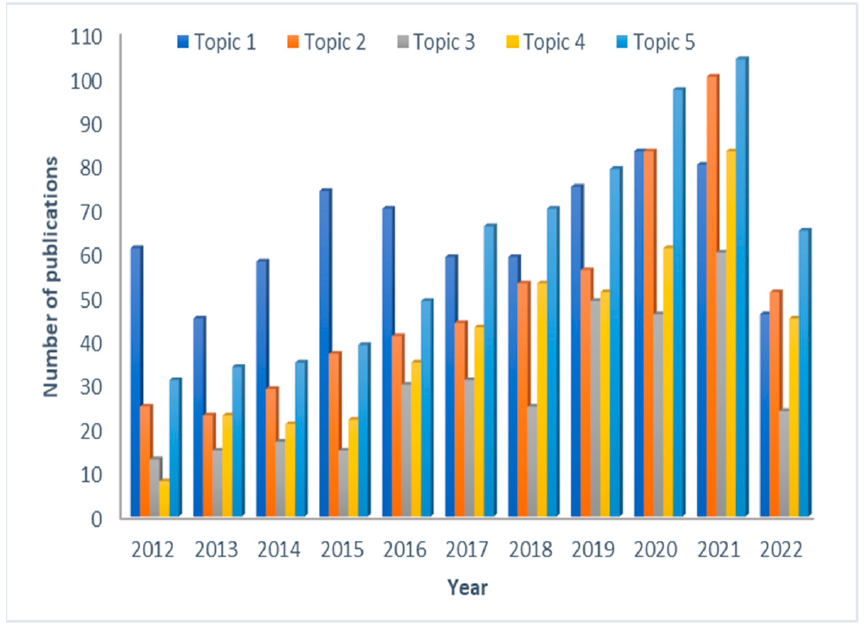
Figure 6. Growth in the number of published papers within each topic in the past 10 years.